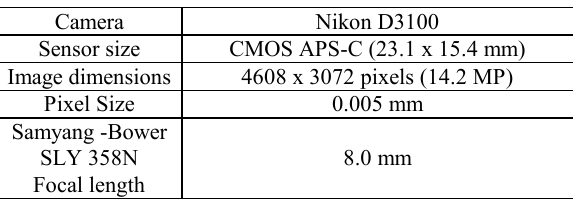
Table 2. Technical data of the Nikon D3100 digital camera and Bower fisheye lens.